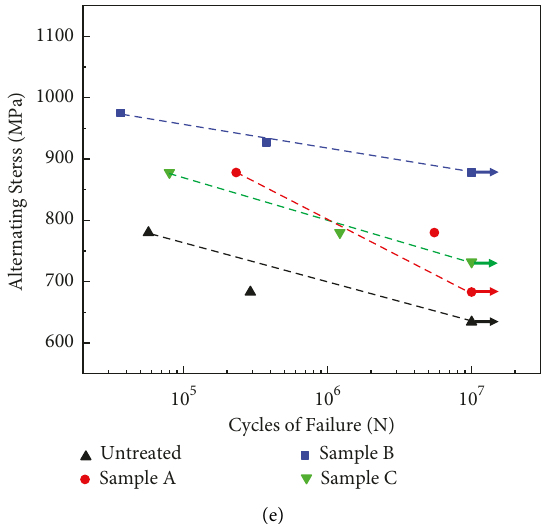
Figure 4: SEM fractographs. (a) Untreated sample, 682MPa, 291,200 cycles, air. (b) Sample A, 780MPa, 5,523,200 cycles, air. (c) Sample B, 926MPa, 367,700 cycles, air. (d) Sample C, 780 MPa, 1,217,500 cycles, air. (e) S-N curves of fatigue